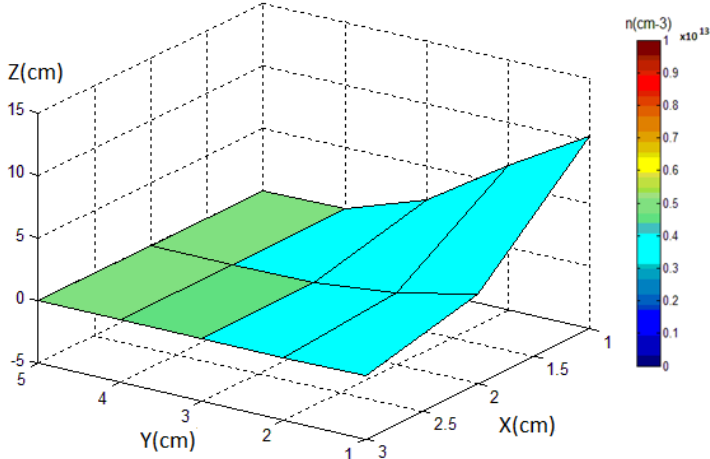
Figure 5: The spatial profile of electron number density of carbon laser induced plasma at